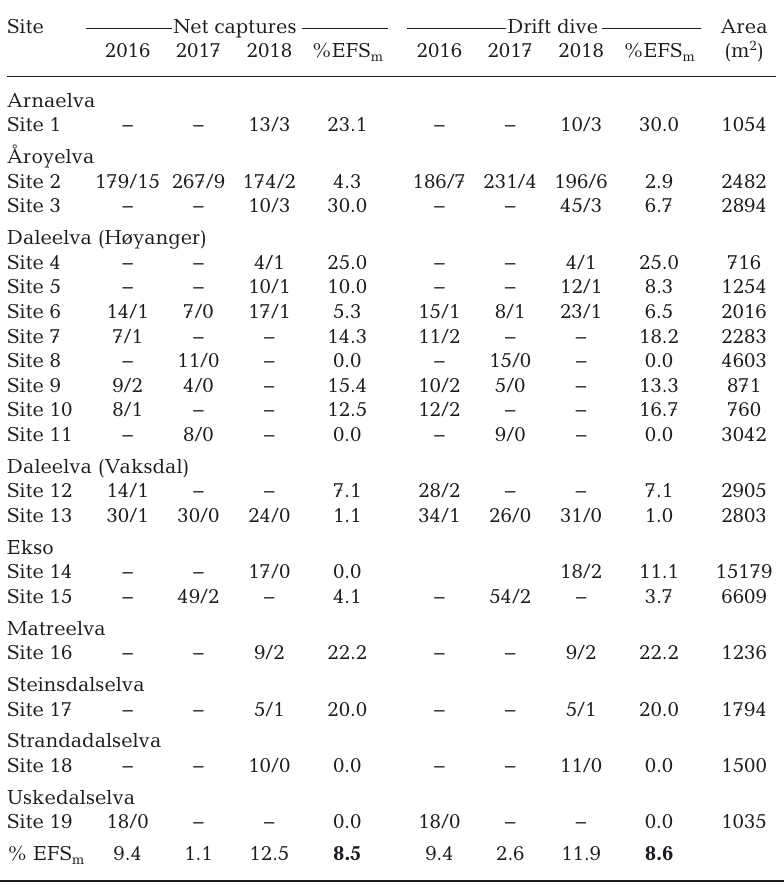
Table 1. Site, net captures, and drift dive observations of Atlantic salmon for each sampling year. First number: total captures; second number: total number of es- caped farmed salmon (EFS). %EFS m : mean proportion of escaped salmon for each year (bottom row) and site (column); bold %EFS m numbers indicate the mean for each method. Site 3 was removed from the overall analysis due to biased sampling during net